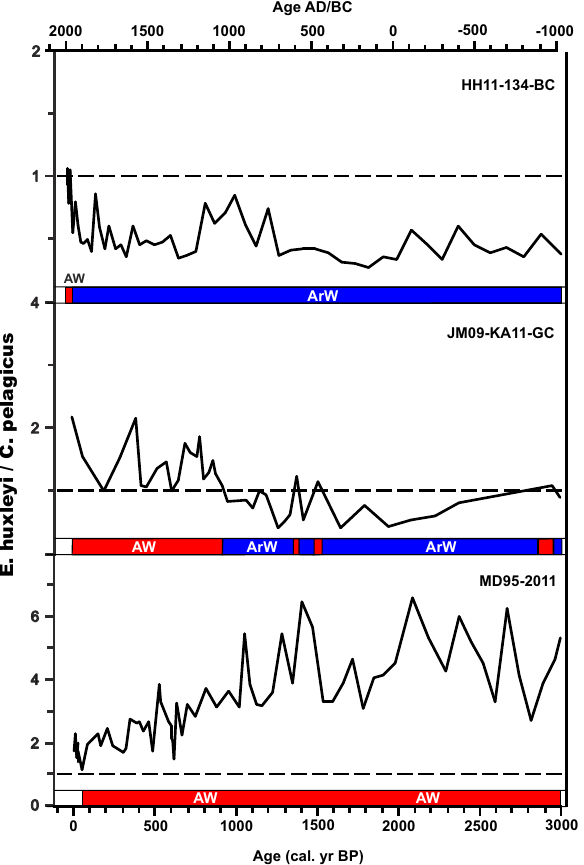
Fig. 5. E/C ratios of the dominant coccolithophore species E. hux- leyi (E) and C. pelagicus (C). The bar charts below each E/C plot highlight the dominating surface water masses at the core locations according to the “1” threshold: blue represents ArW (E/C < 1); red represents AW (E/C > 1).